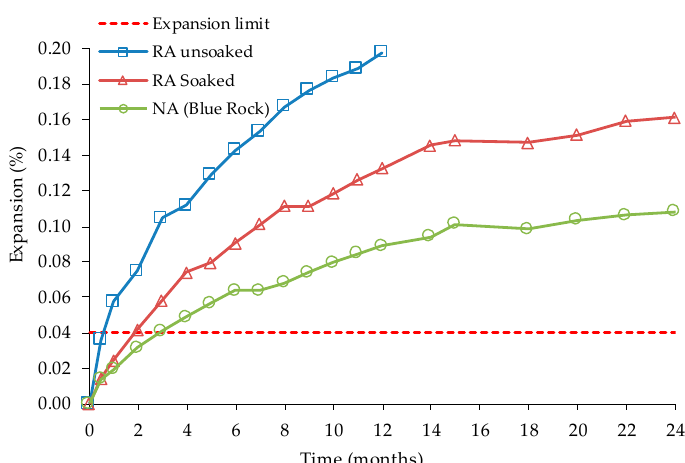
Figure 7. Expansion of saturated and unsaturated NA and RA in the ASTM C 1293 test, adapted from [78].